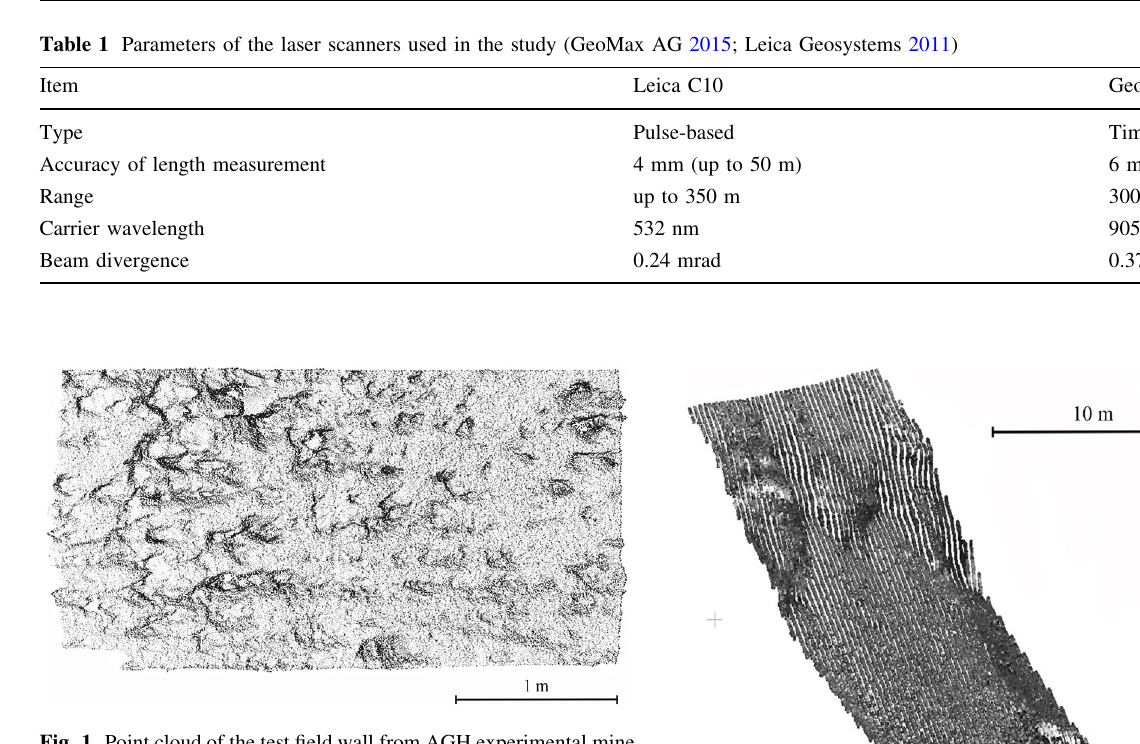
Fig. 1 Point cloud of the test field wall from AGH experimental mine